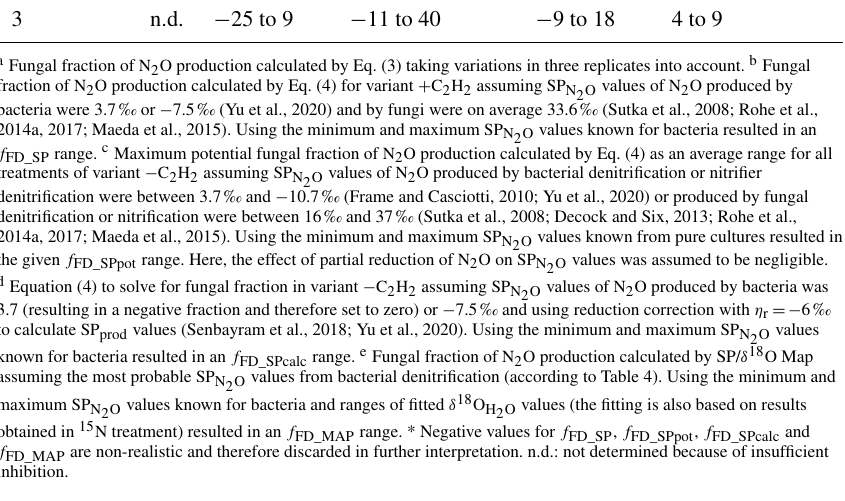
values 2 O and SP N values from variant − C 2 H 2 and variant 2 O 2 O